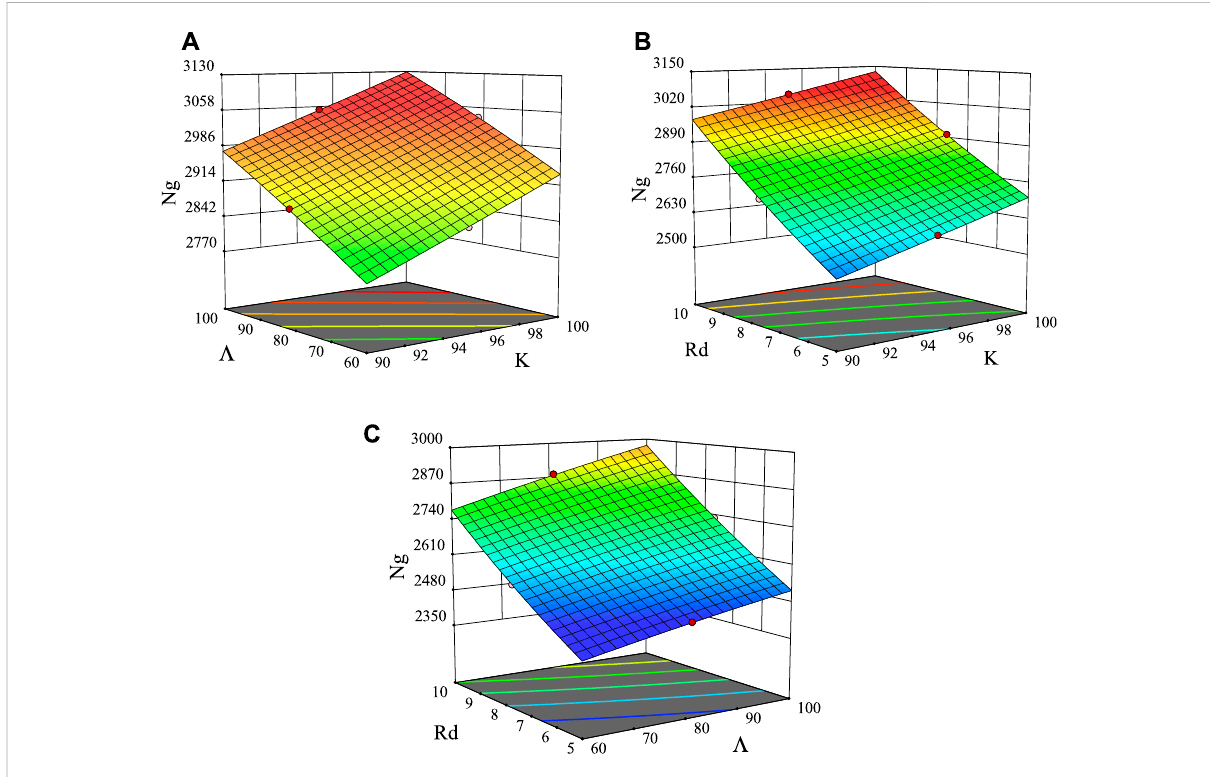
FIGURE 7 3-Dresponsesurfaces:interactivein fl uencesofvaried (A) buoyancyandmaterialparametersatRd=10, (B) radiationandmaterialparametersat Λ = 100, (C) radiation and buoyancy parameters at K = 90.